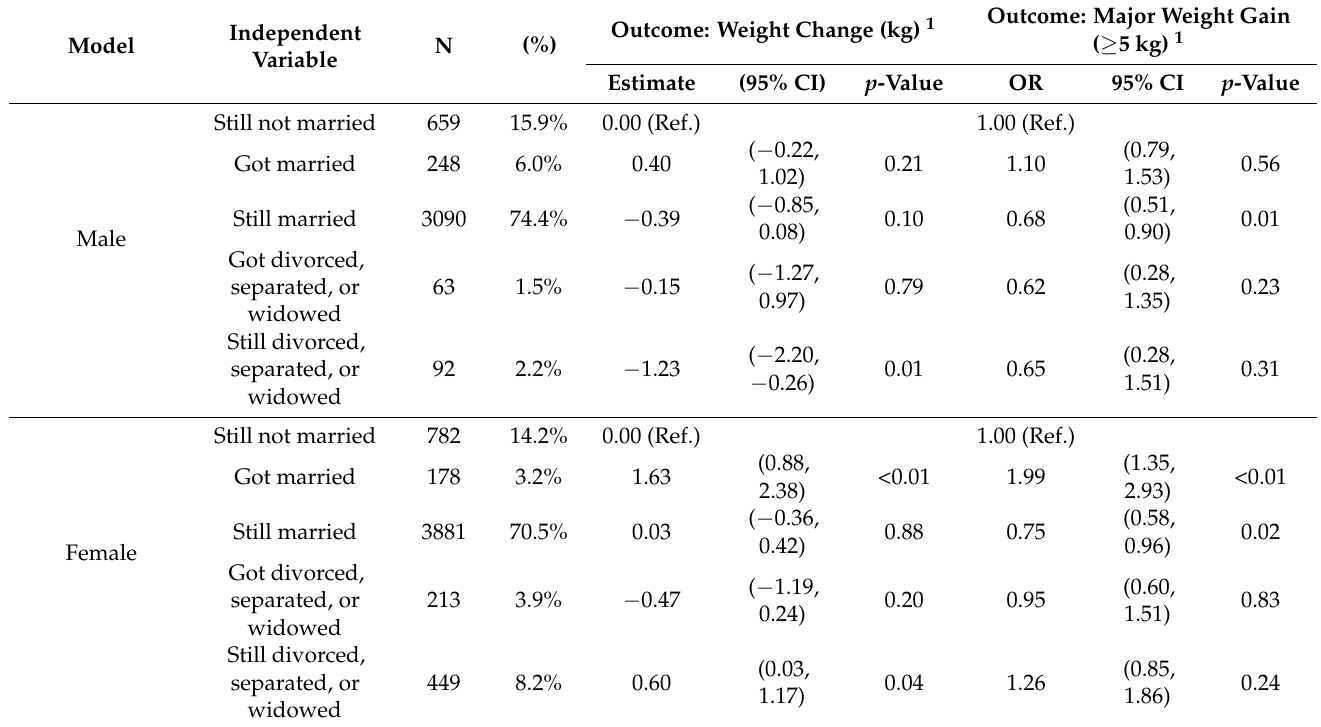
Table 4. Associations between changes in marital status and weight change stratified by sex in Singapore Multi-Ethnic Cohort participants aged 21 years and